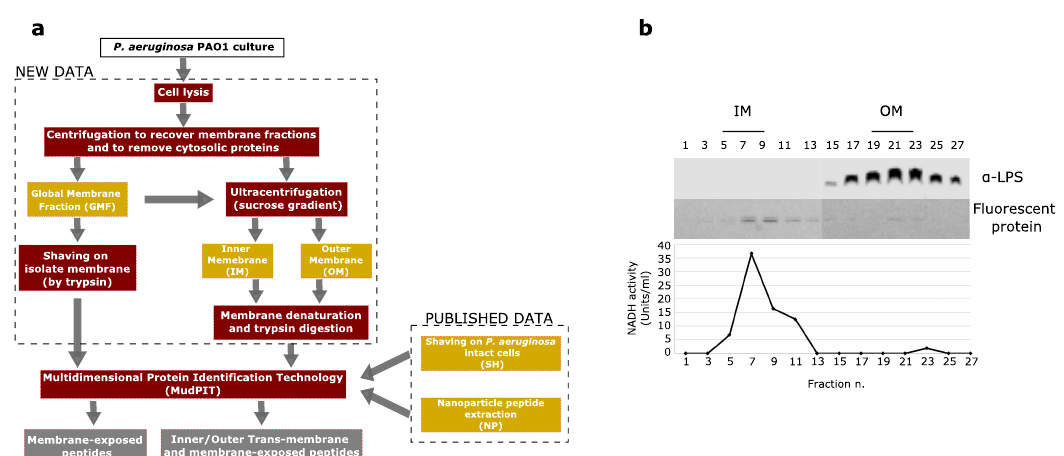
Figure 1. ( a ) Workflow for extracting and enriching exposed and embedded peptides from P. aeruginosa inner (IM) and outer (OM) membranes. GMF: global membrane fraction. SH: Shaving on intact P. aeruginosa cells. NP: peptide/protein extraction by Nanoparticles. ( b ) P. aeruginosa inner (IM) and outer (OM) membranes separated by sucrose gradient ultracentrifugation. IM and OM containing fractions were verified by the profile of NADH oxidase activity and distribution of LPS,